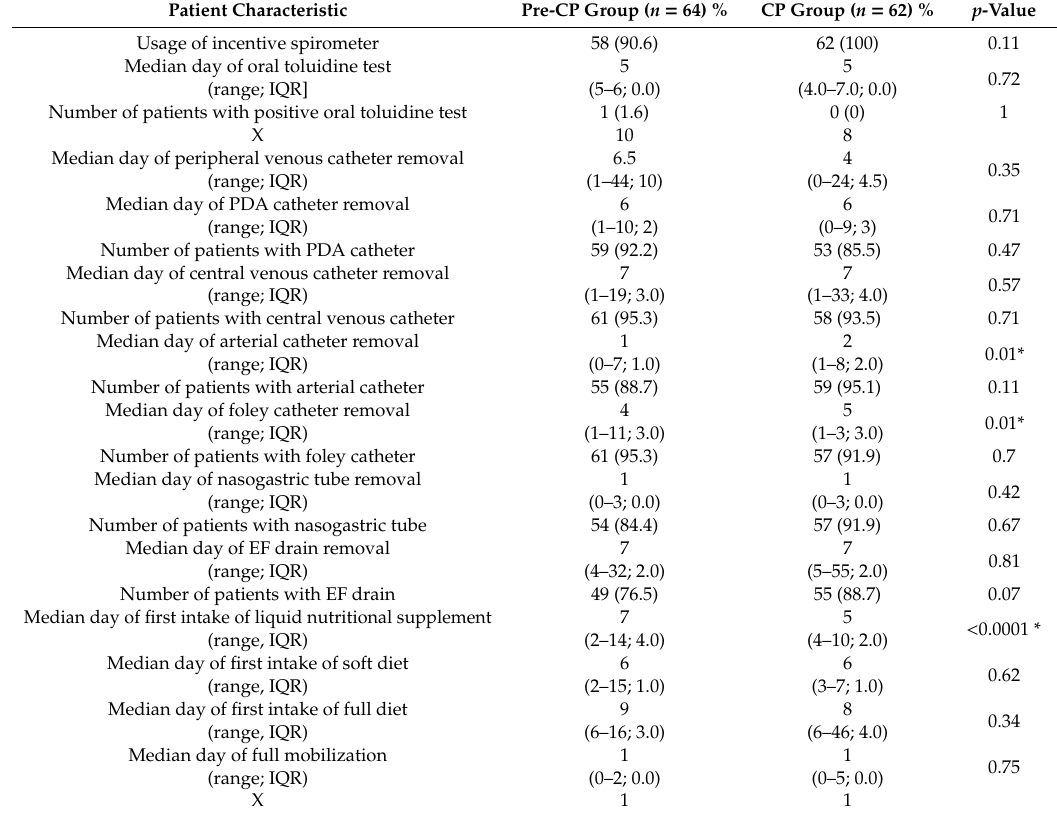
Table 2. Parameters of process